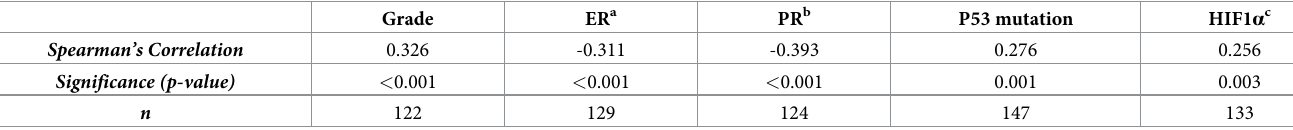
biopsies as described in Fig 4A. Associations with a p-value of � 0.05 were considered to be statistically relevant. All statistical analysis was computed in SPSS